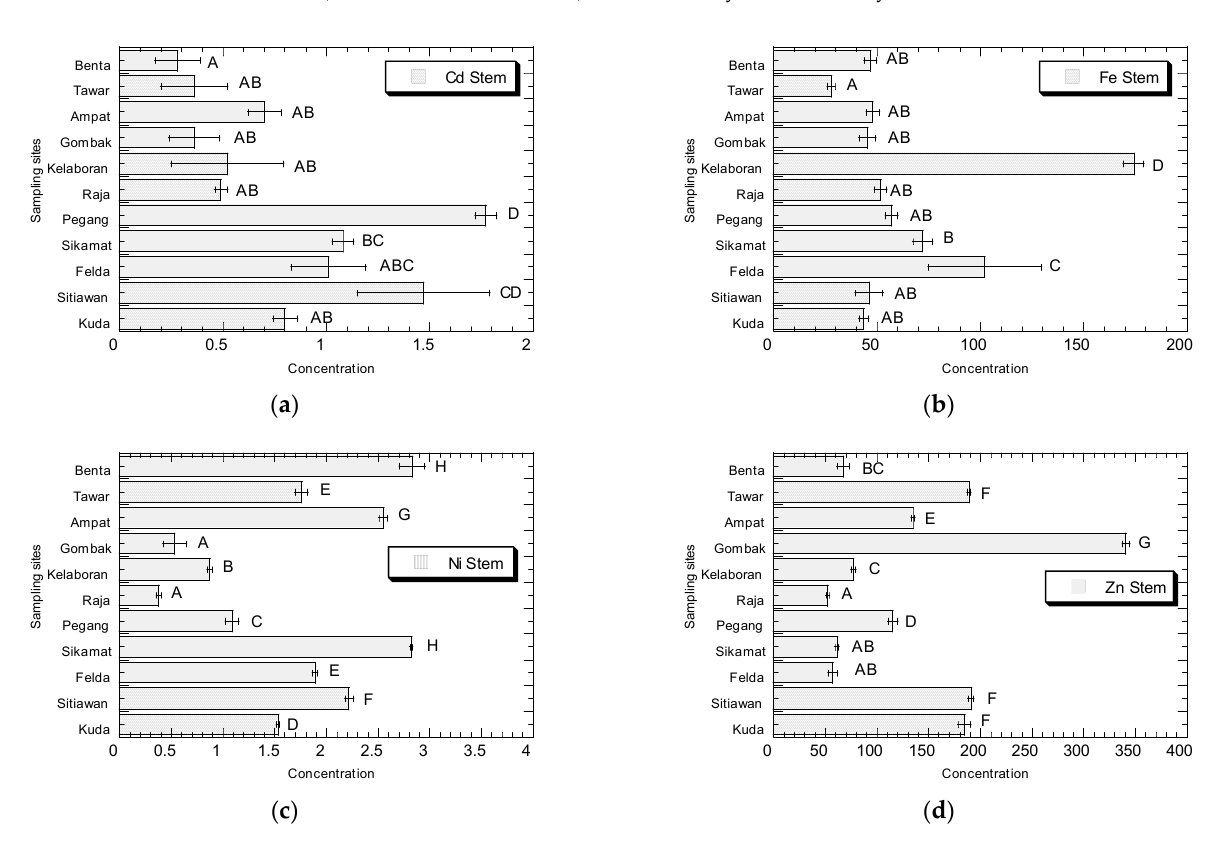
Figure 2. Concentrations (mean ± SE, µg/g dry weight) of Cd ( a ), Fe ( b ), Ni ( c ), and Zn ( d ) in the leaves of Amaranthus viridis collected from all the sampling sites in Peninsular Malaysia. Metal concentrations sharing a common letter are not significantly different ( p > 0.05) based on the post-hoc test (Student–Newman–Keuls) in the one-way ANOVA analysis.